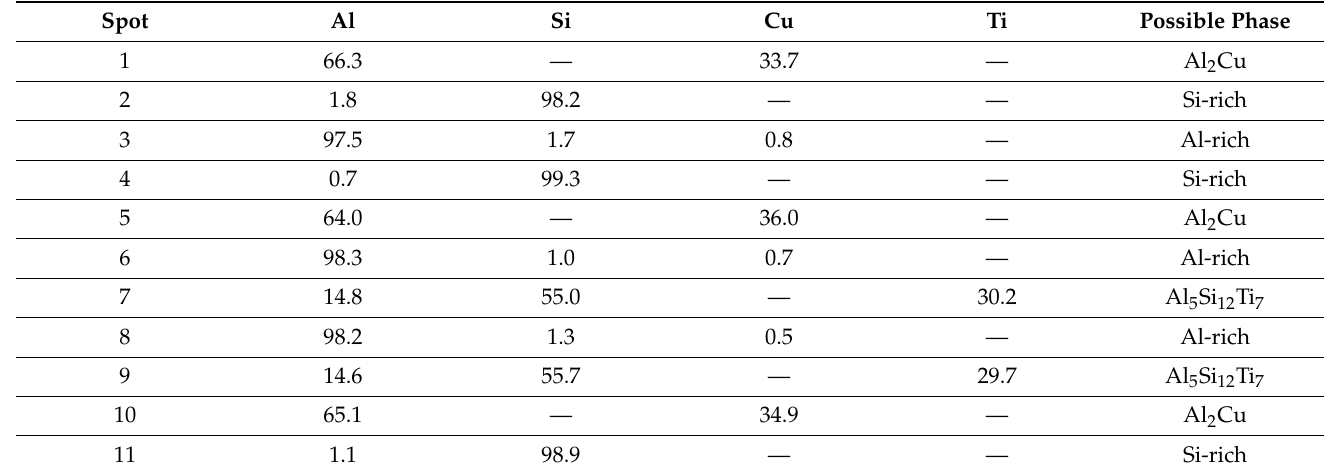
Table 3. The EDX analysis results of the filler alloys (at.%).